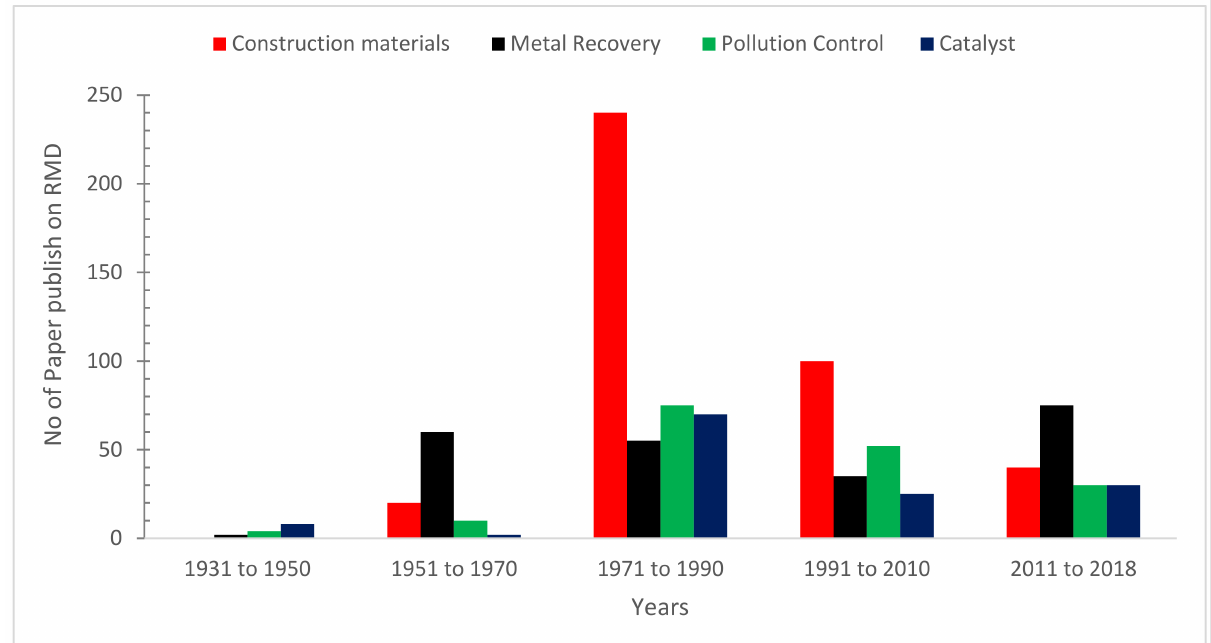
Figure 4. No. of Publication on RMD (1931 to 2018): Data Source